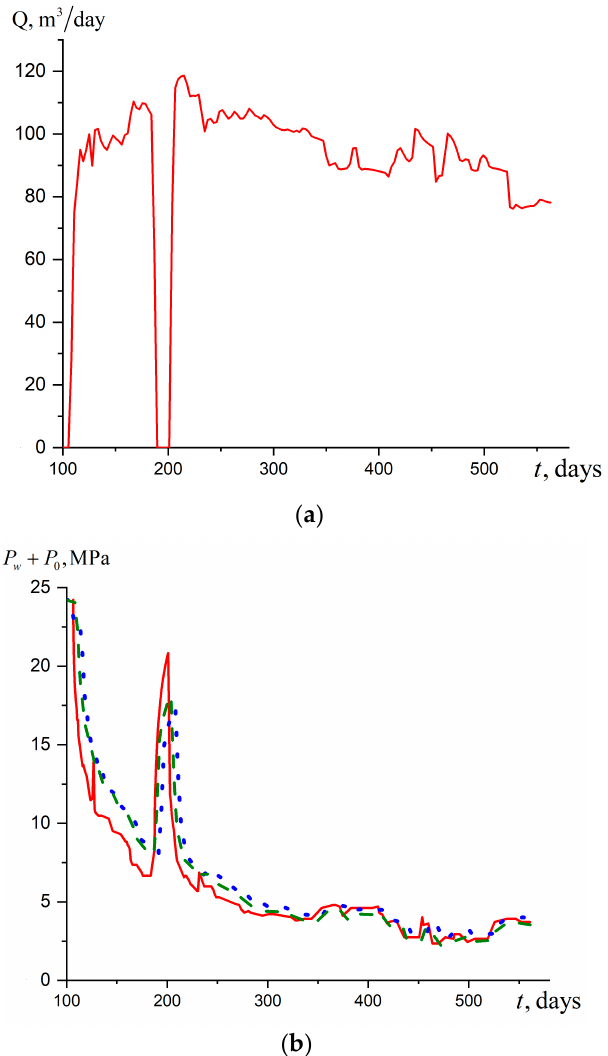
Figure 5. ( a ) production rate; ( b ) the pressure comparison: the initial field pressure (red solid line), analytical formulae (green dashed line) and the approximate method of successive change of stationary-states method (blue dotted line).